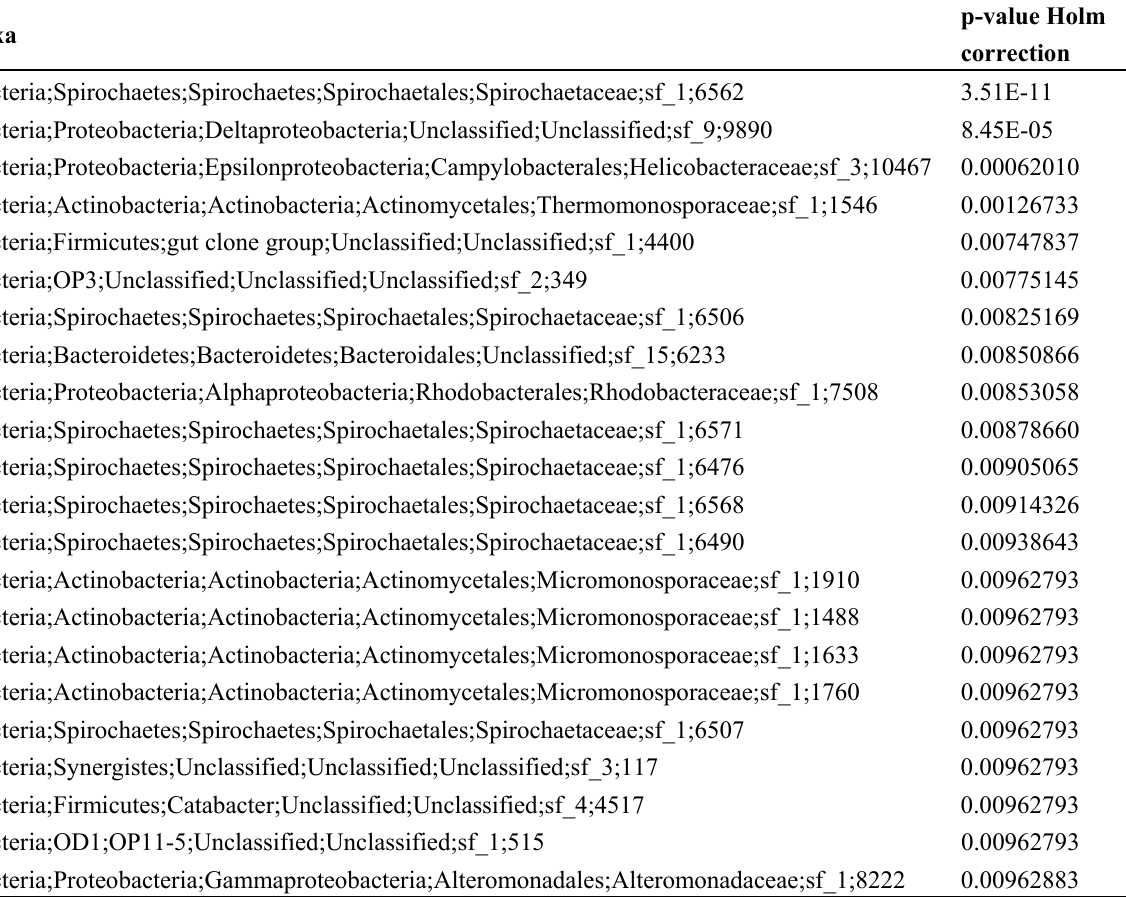
Table S2. PhyloChip-OTUs statistical significance of ANOVA results, indicating differences between domestic and feral goats (p <